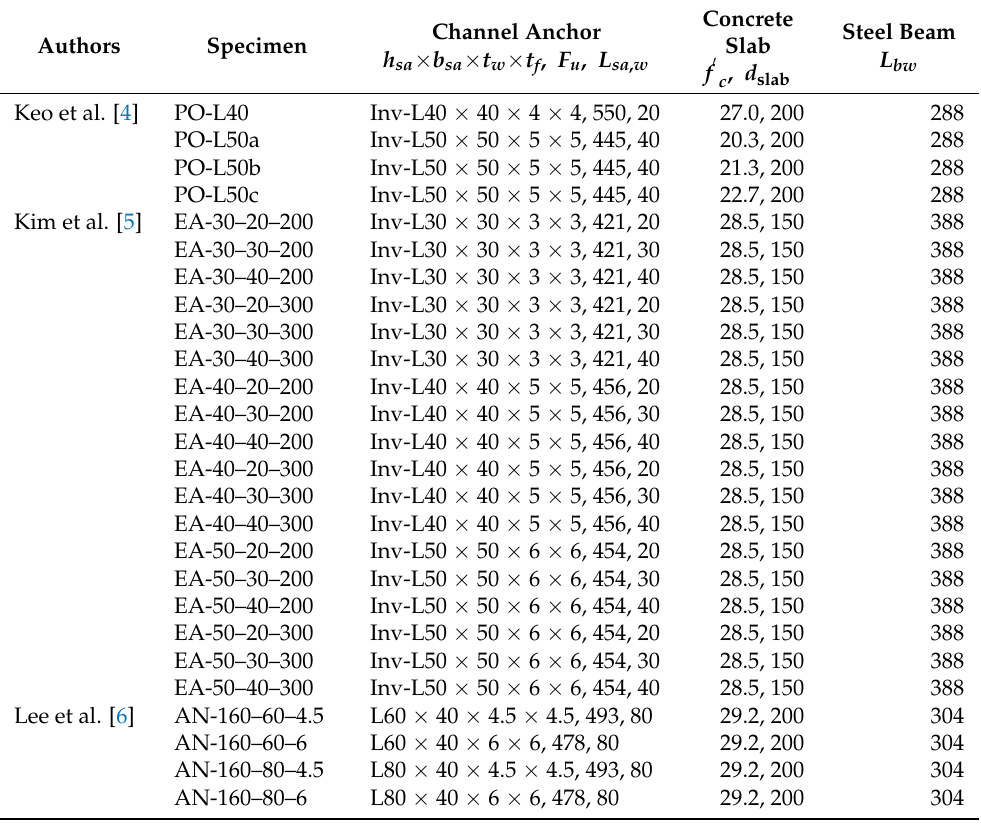
Table A1. Test Parameters of Previous Studies for Channel Anchor with Partial-length Welding (units in mm,